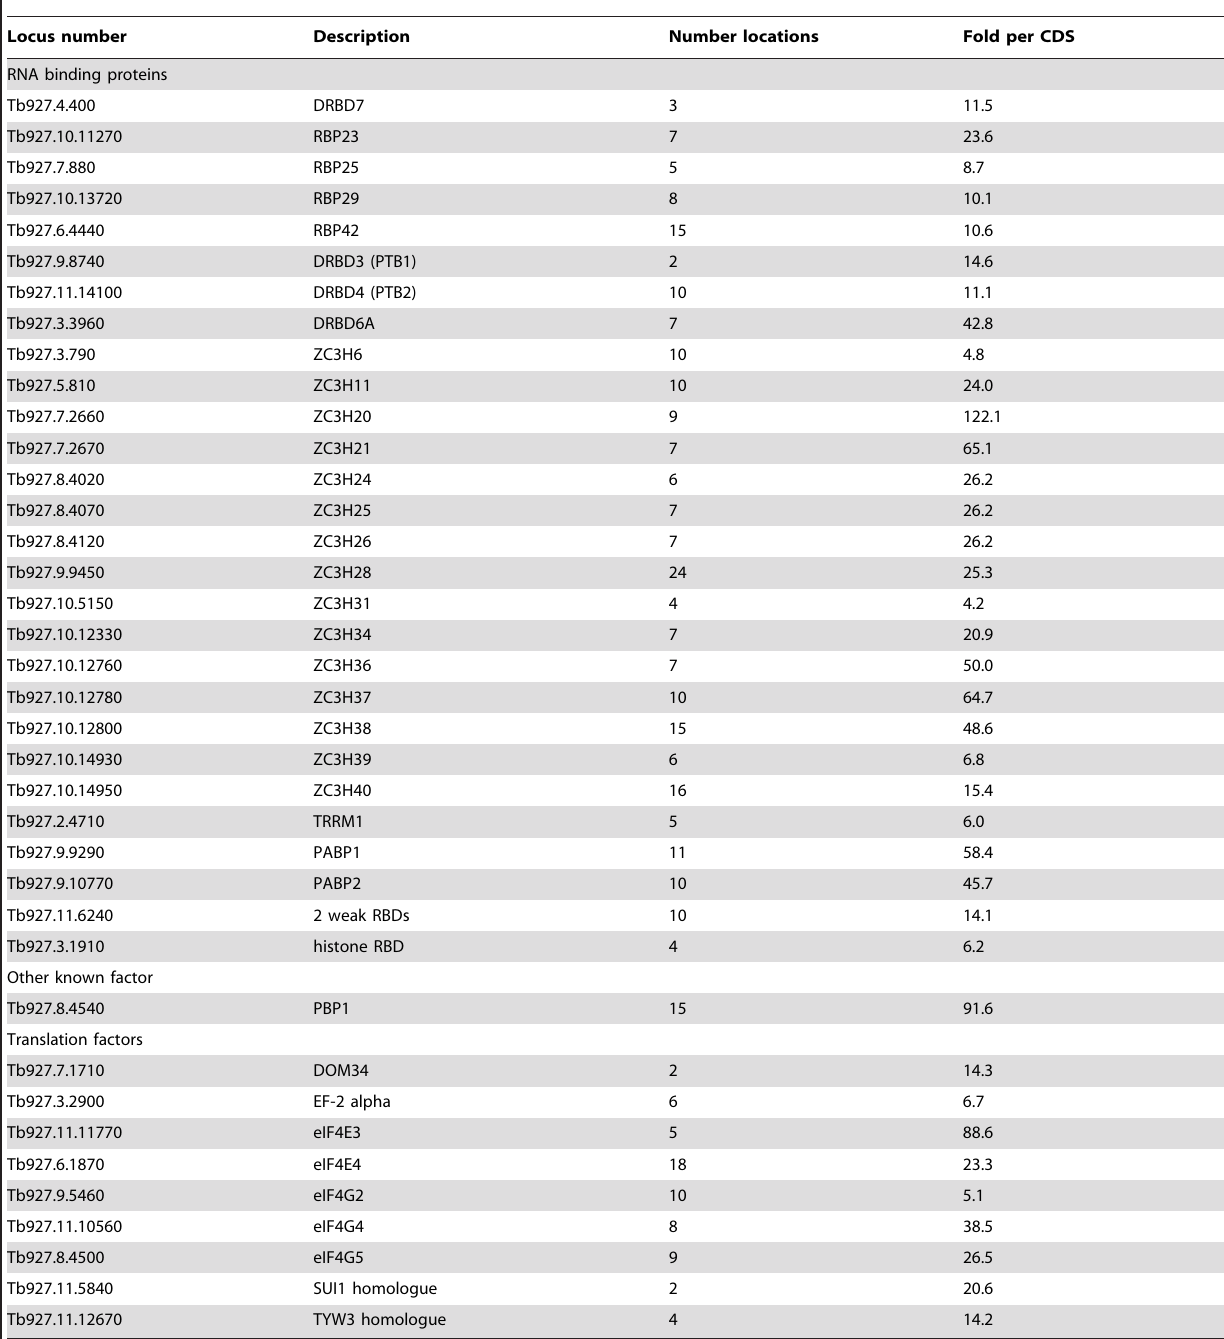
Table 1. RNA-binding proteins and translation factors that increase BLA resistance.